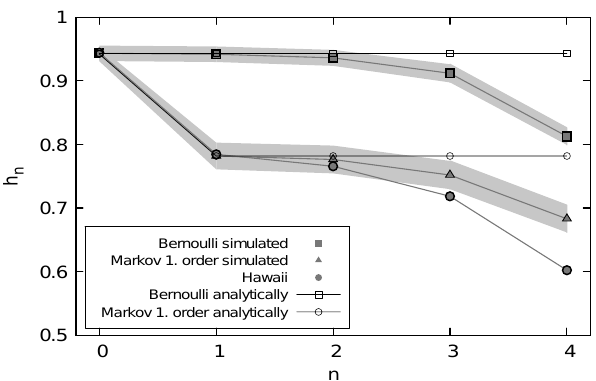
Fig. 5. Theoretical and estimated conditional entropies for several